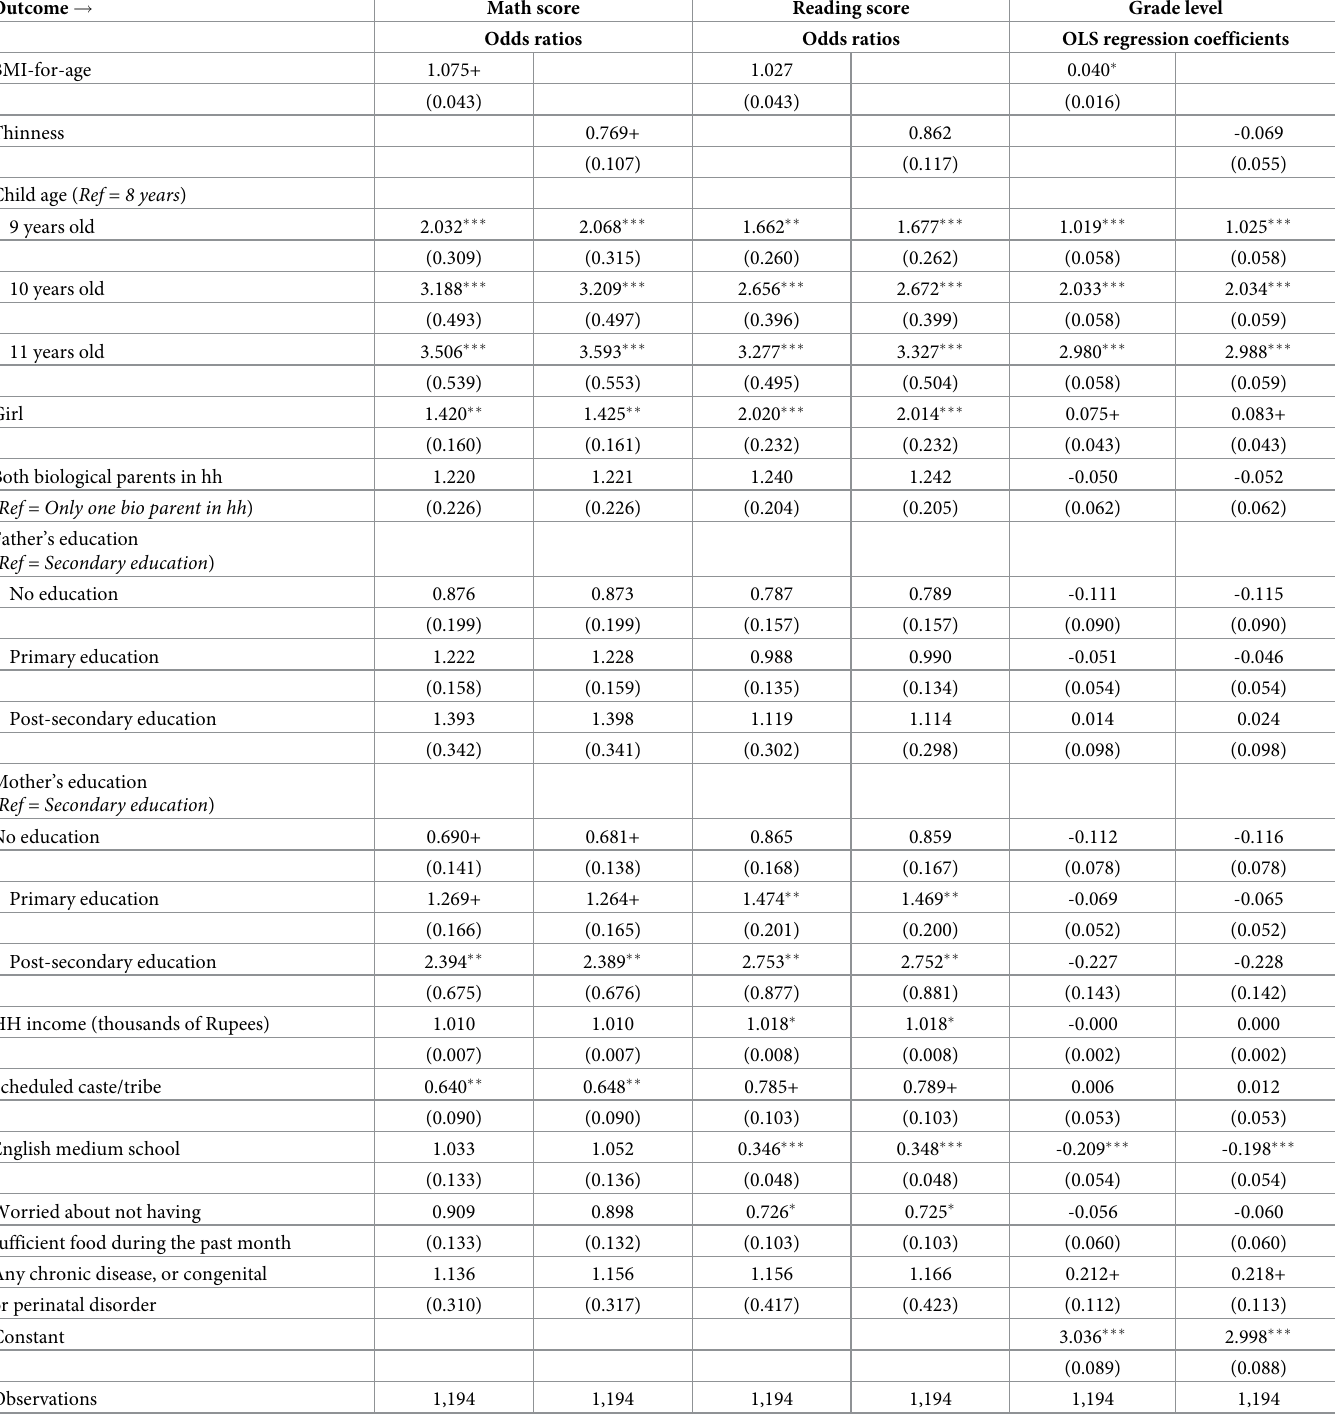
Table 3. Adjusted models for the association between cognitive achievement and educational attainment and BMI-for-age z-scores and